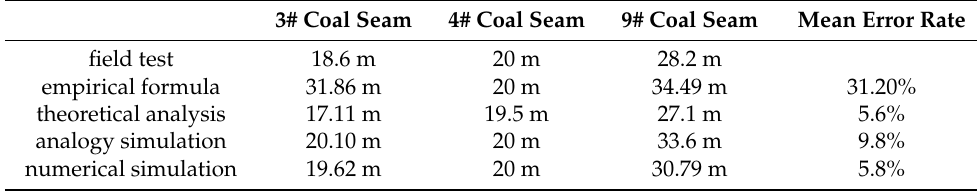
Table 6. Analysis and comparison of the measured data of the water-carrying fracture zone.